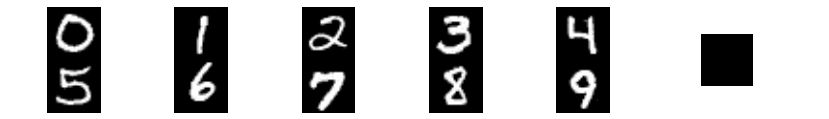
Figure 6. Ground truth labels are used to train the generator. For example, the network being trained to recognize or generate the digit “1” is given the ground truth image for “1” and the blank image for all other digits.